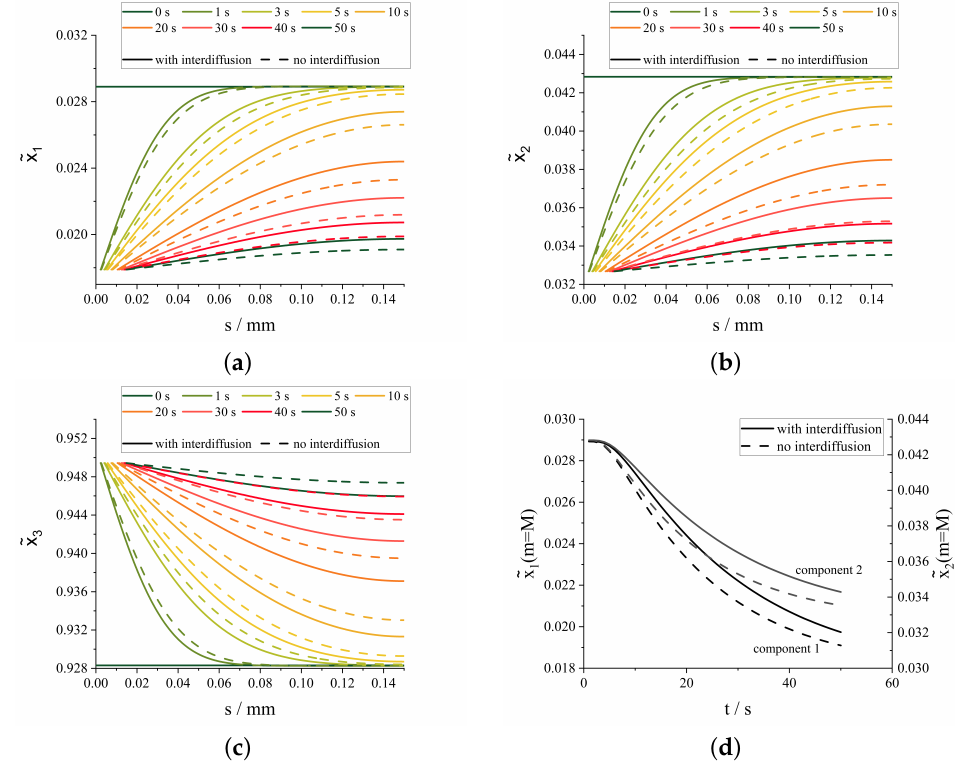
Figure 6. Time and space evolution of molar fractions of component 1 ( a ), 2 ( b ), and 3 ( c ) in solution. Diagram ( d ) depicts the development of the concentration ˜ x i at the point m = M over time. Simultaneous crystallization of component 1 and 2 are shown with and without consideration of cross-diffusion effects. Full lines represent cases with consideration of cross-diffusion. Dashed lines show results of simulation without consideration of